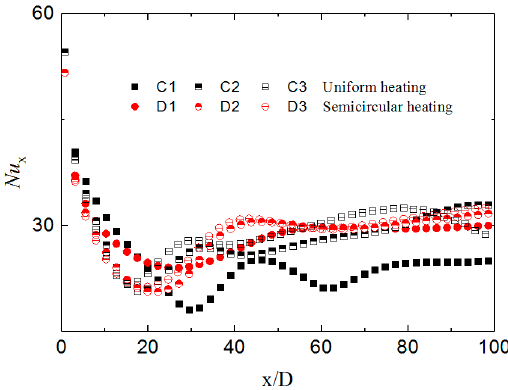
Figure 6. Nusselt number ( α =90°).